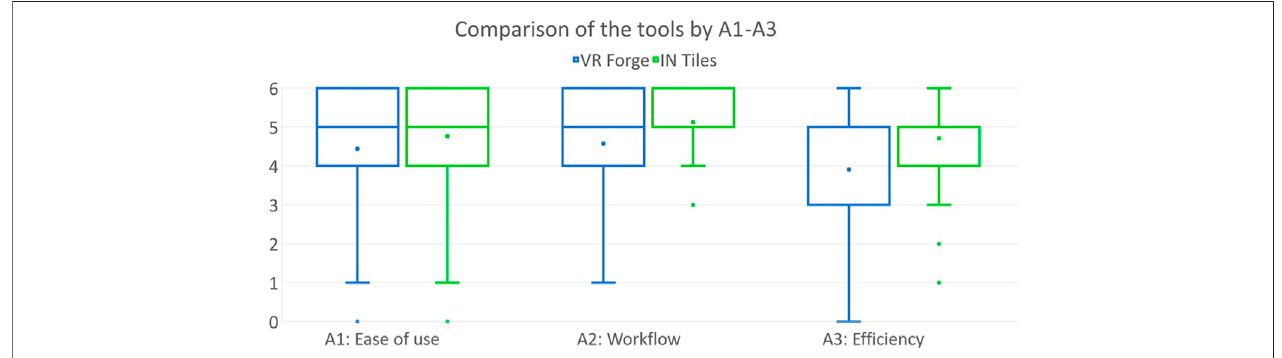
FIGURE 12 | Box and whisker plots comparing the authoring tools by A1 –